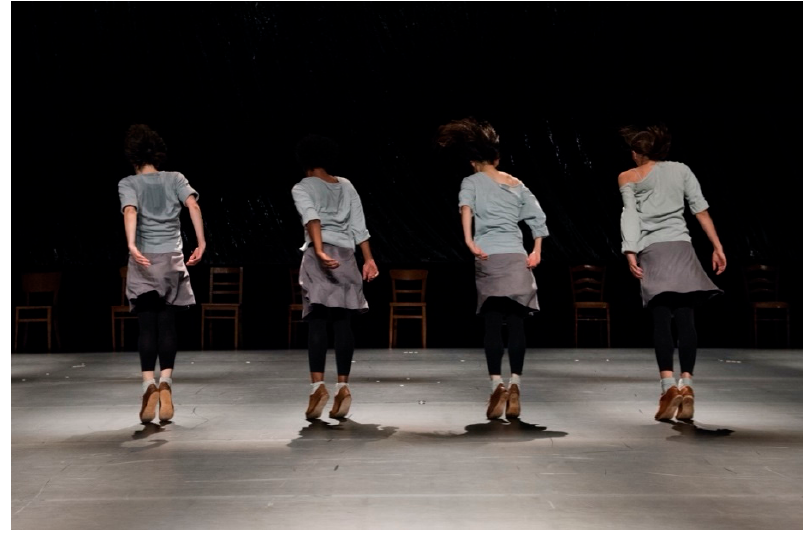
Figure 2. Rosas danst Rosas (2017) Anne Teresa De Keersmaeker/Rosas @ Anne van Aerschot. Used with permission.